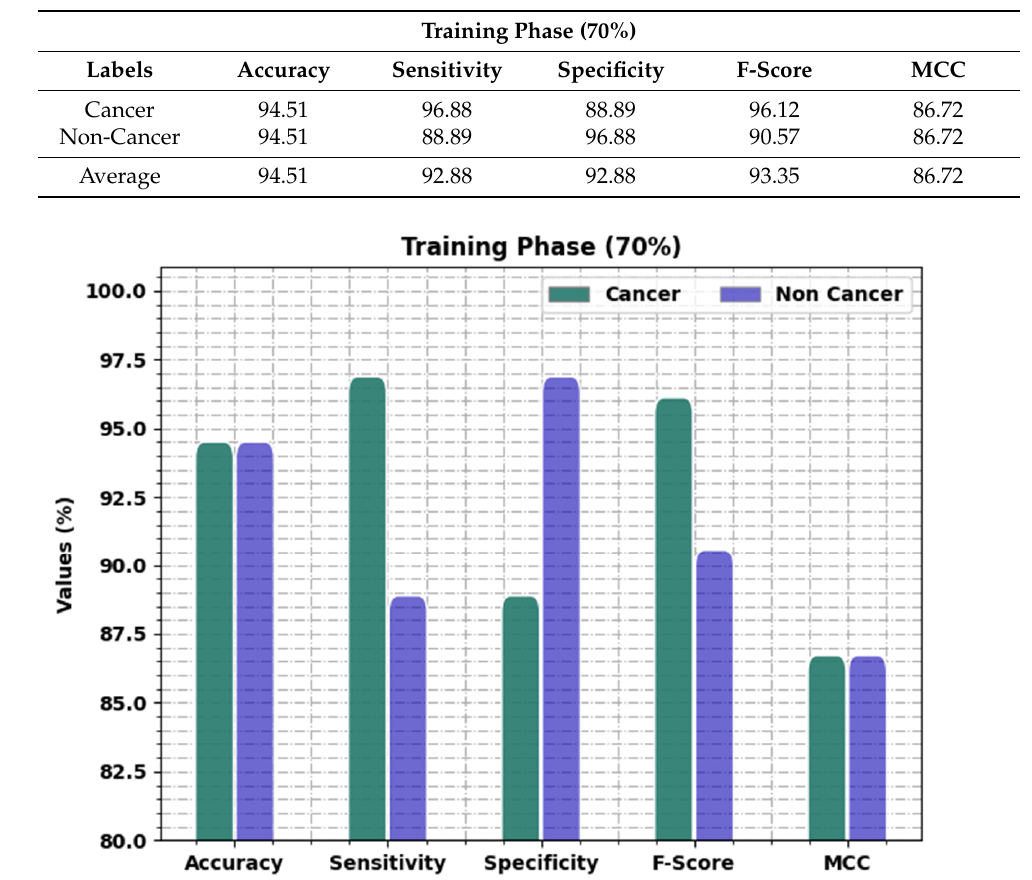
Figure 6. Result analysis of OIDCNN-OPMDD approach under 70% of TR data.